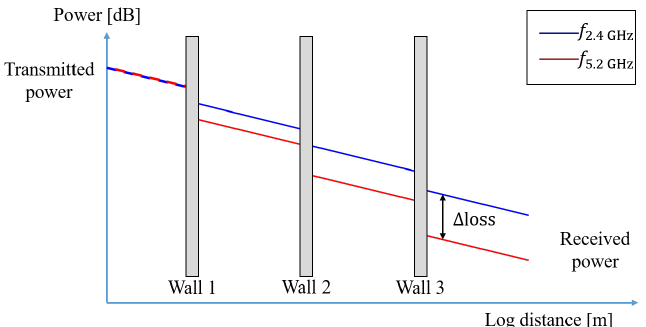
Figure 1. Indoor path loss for the different frequency bands.